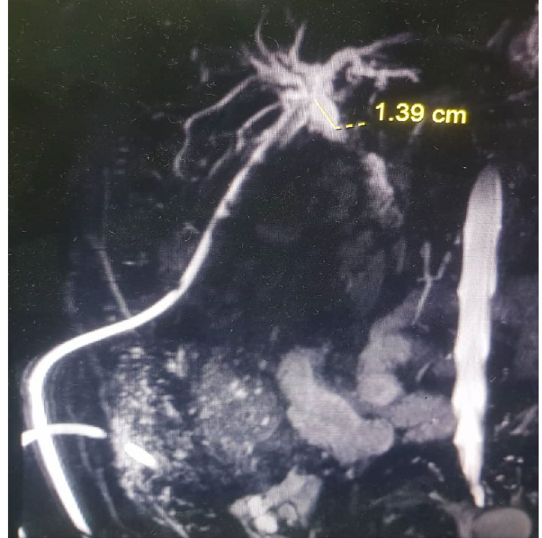
Fig. 2 Massive dilated bilateral intrahepatic bile duct with abrupt cut off at the confluence. CBD and Pancreatic ducts noted with normal